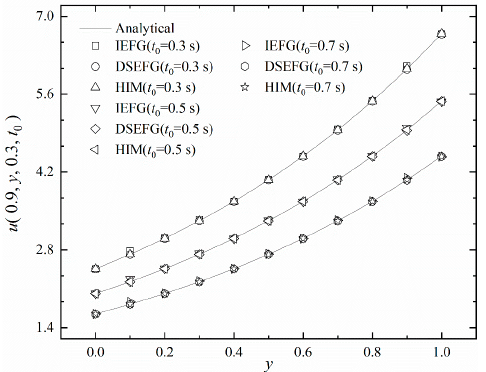
Figure 6. Calculation results along y -axis when t 0 is different.